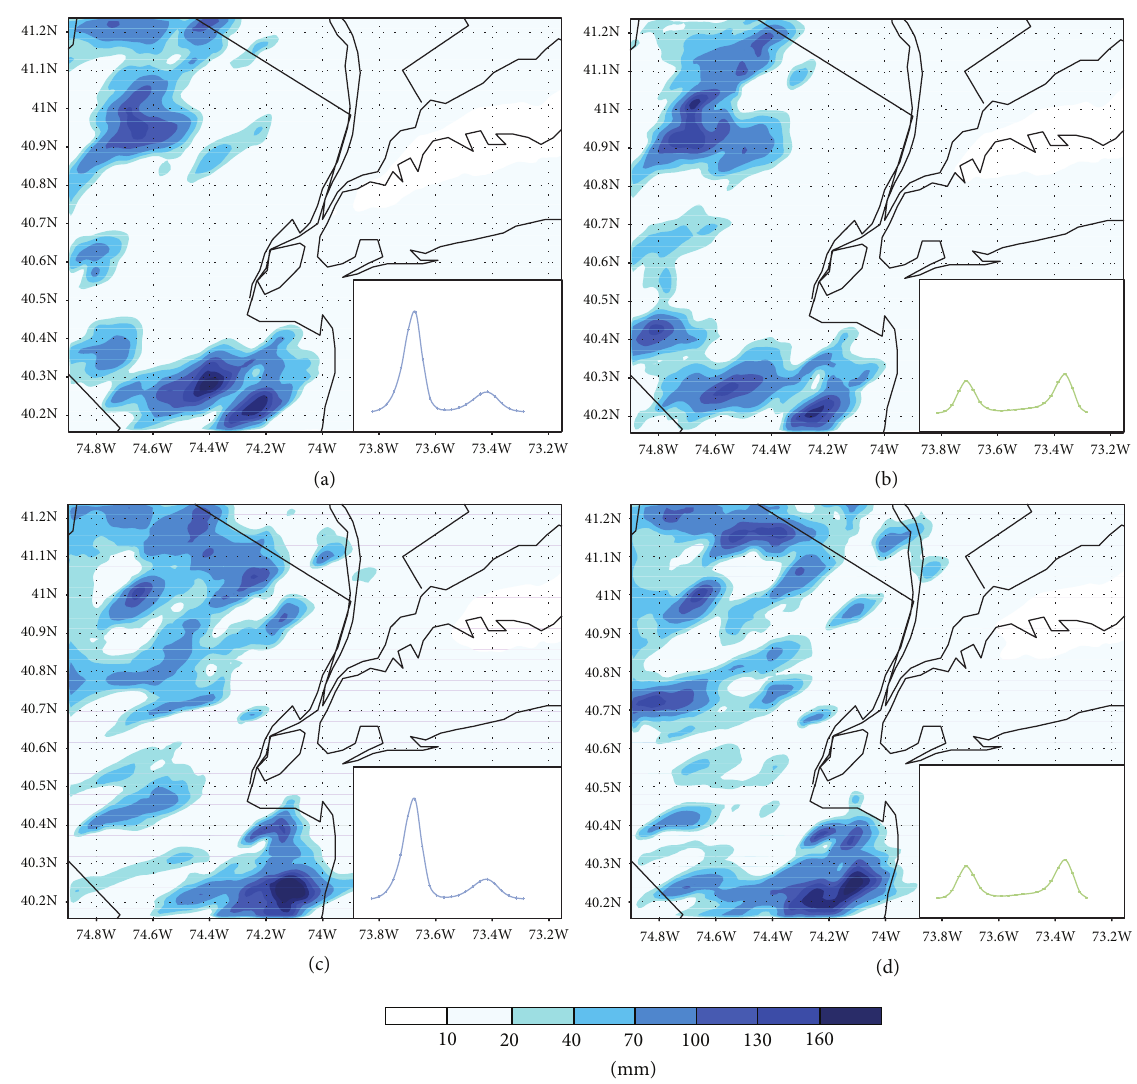
Figure 12: PSD and LCLU variation. (a) HVFM PSD, City (Run 1). (b) HVCM PSD, City (Run 2). (c) HVFM PSD, No City (Run 3). (d) HVFM PSD, No City (Run